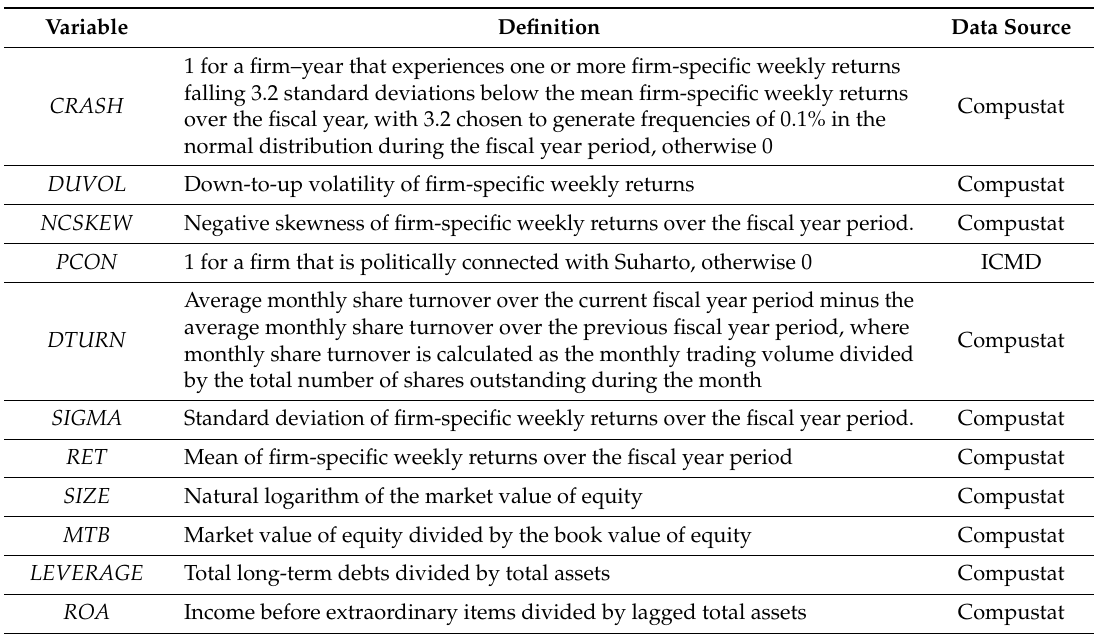
Table A1. Variable